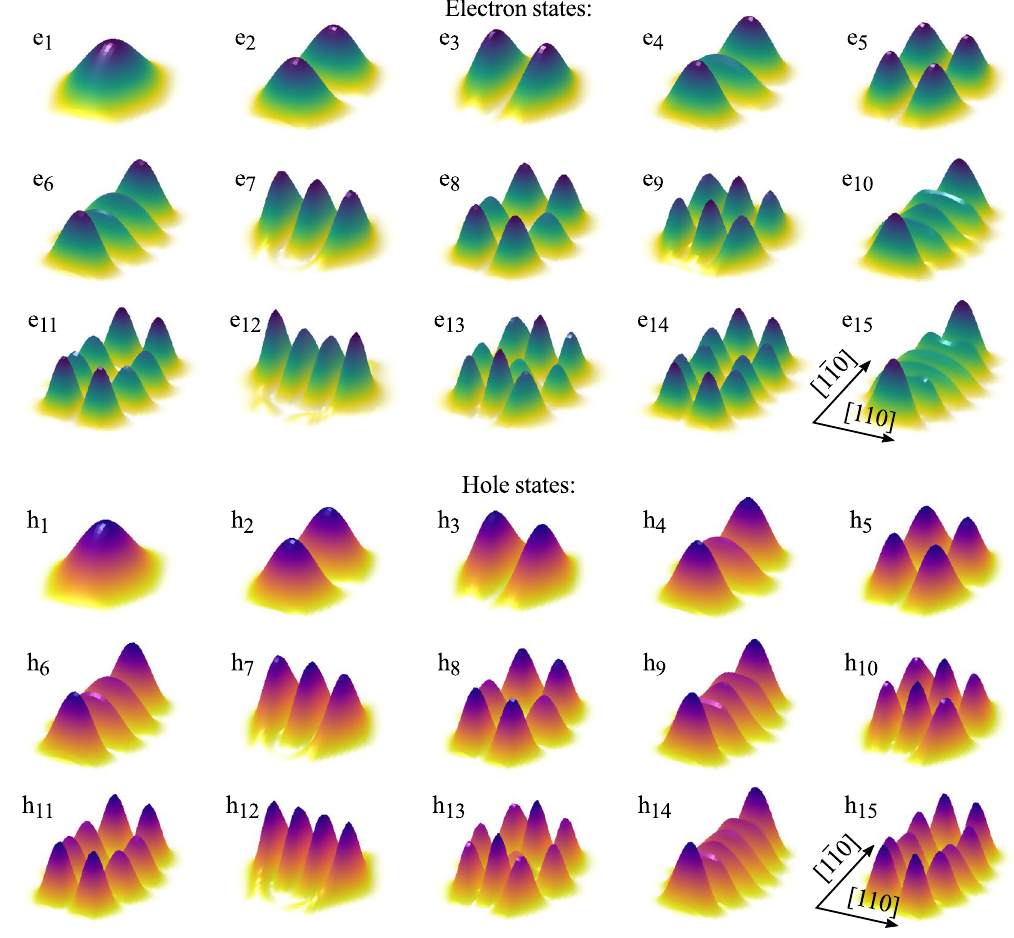
Figure 3. Electron (top) and hole (bottom) eigenstates. The projection, onto the (001) plane, of the probability density in a number of lowest-energy orbital eigenstates for an exemplary InAs/AlGaInAs QD with c L 43 nm, W 33 nm, H 2.4 nm, and α 30 ◦ = = = =